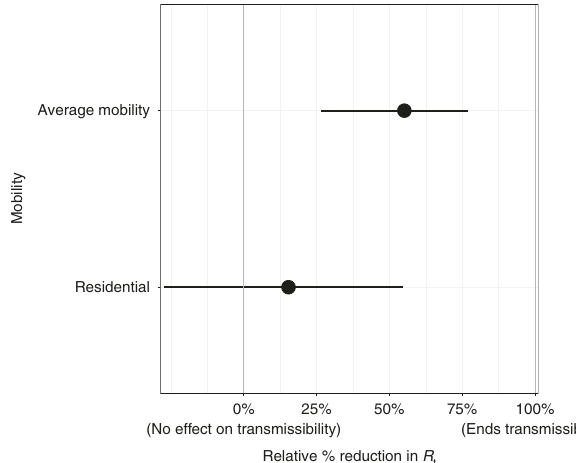
Fig. 3 Country level covariate effect sizes assuming mobility stopped entirely (100% reduction in average mobility) and residential mobility was increased fully (100% increase in residential mobility). Average mobility combines “ retail & recreation ” , “ grocery & pharmacy ” , “ workplaces ” . The error bars show 95% credible intervals and the dots show the mean estimate. The sample size n = 105,006 deaths across the 50 states and the District of Columbia up until 1 June and 479,422 cases from 11 May to 1